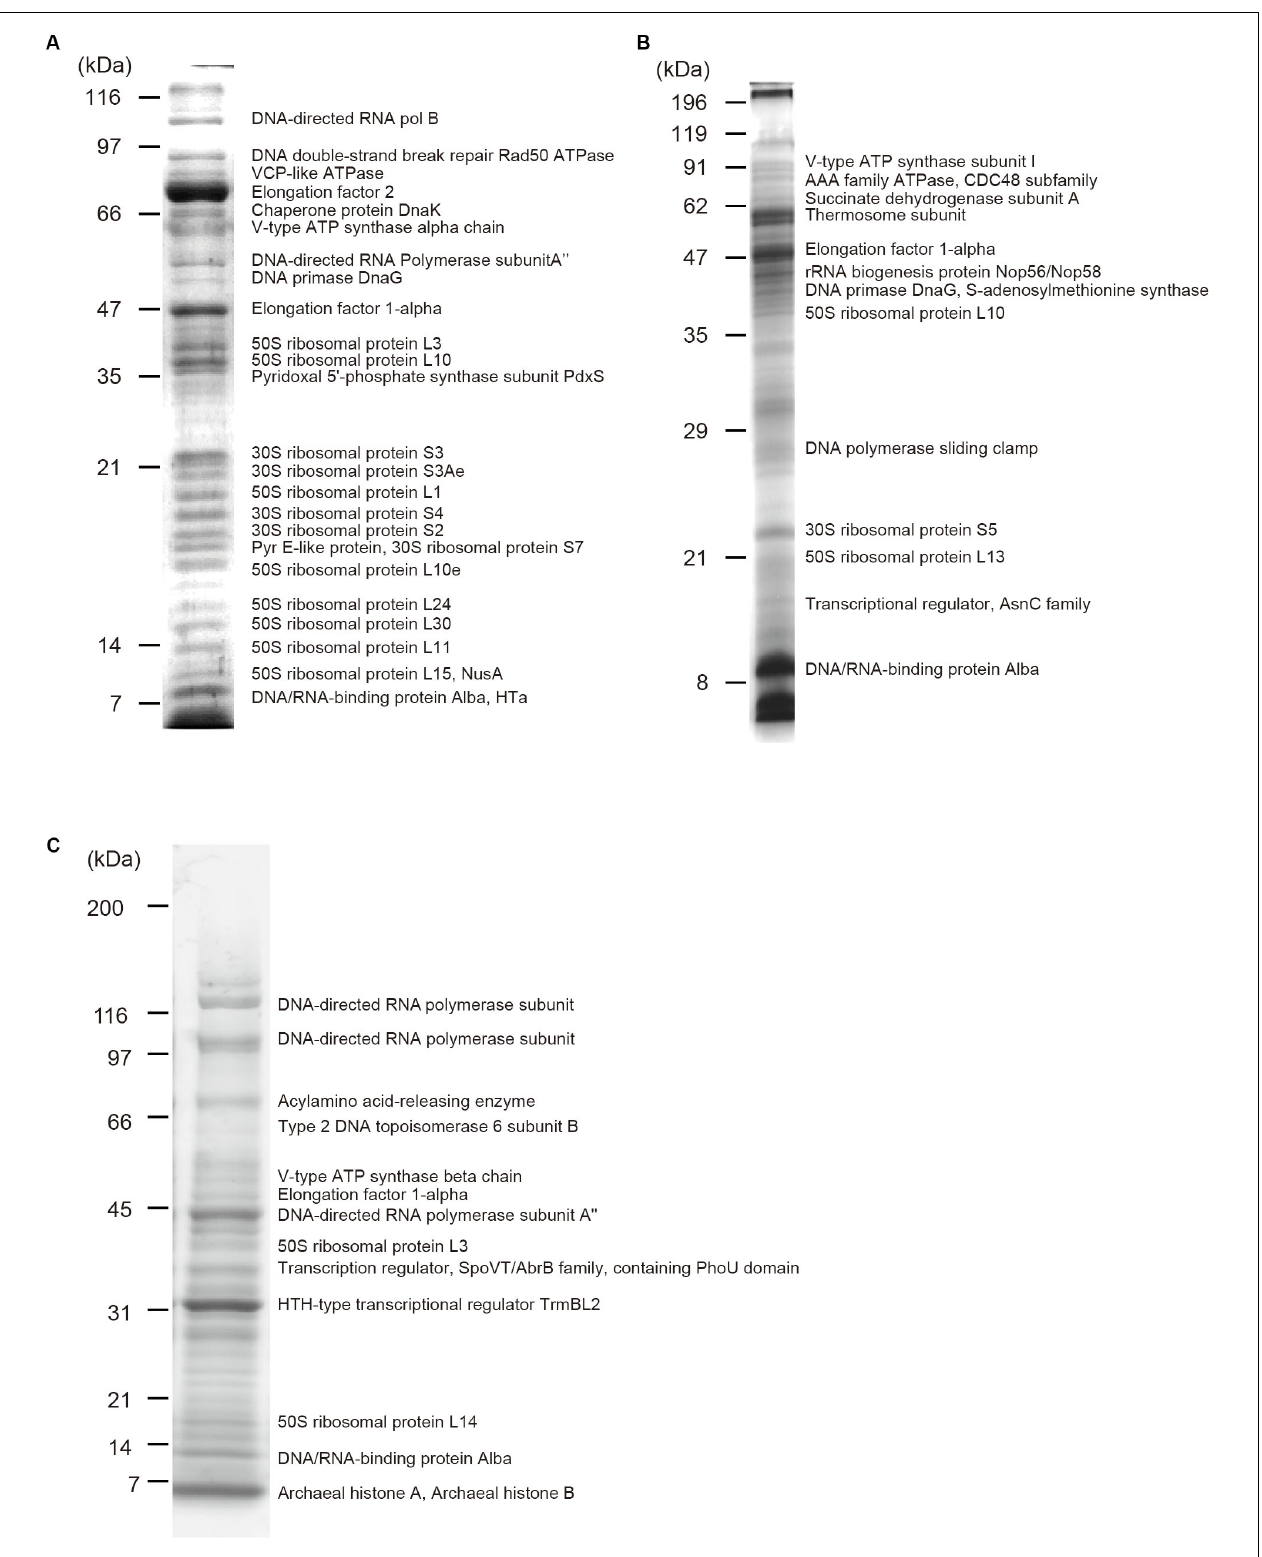
FIGURE 4 | Protein components of isolated chromosomes. Chromosomes isolated from (A) T. acidophilum (B) P. calidifontis (C) T. kodakarensis were digested with MNase, separated through SDS-PAGE and stained with Comassie Brilliant Blue. Representative proteins detected with mass spectrometry are indicated next to the corresponding bands. See Tables 1–3 for